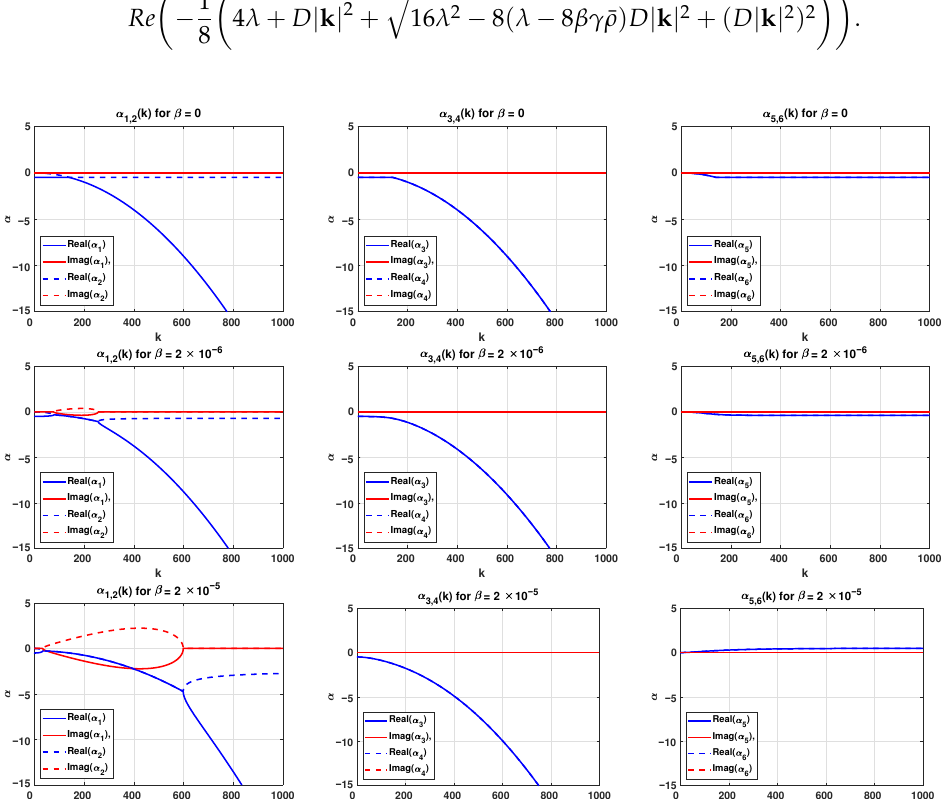
Figure 7. The six eigenvalues versus the wave number k plotted for different β values. Here we have D = 0.0001, ρ 1 = ρ 2 = ρ 3 = 50,000 with the γ